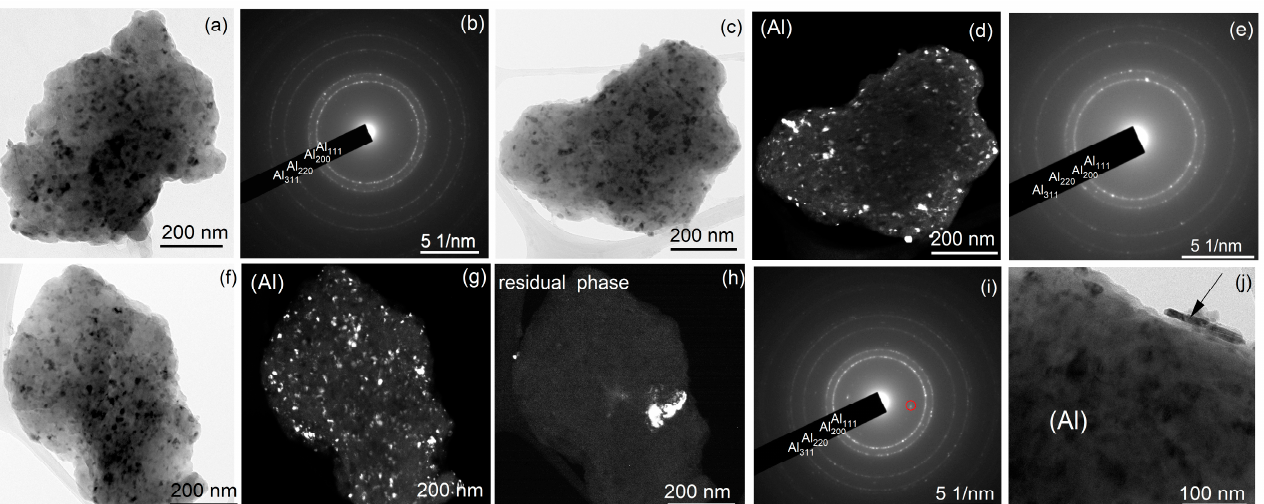
Figure 6. TEM structure of ( a , b ) sample A after milling for 20 h and ( c – j ) the pre-milled sample B after milling for ( c – e ) 20 h and ( f – j ) 40 h; ( a , c , f , j ) bright field images, ( d , g , h ) dark field images, and ( b , e , i ) the corresponding SAEDs; the red-colored ring in SAED ( i ) is the reflection for the dark field image presented in ( h ).